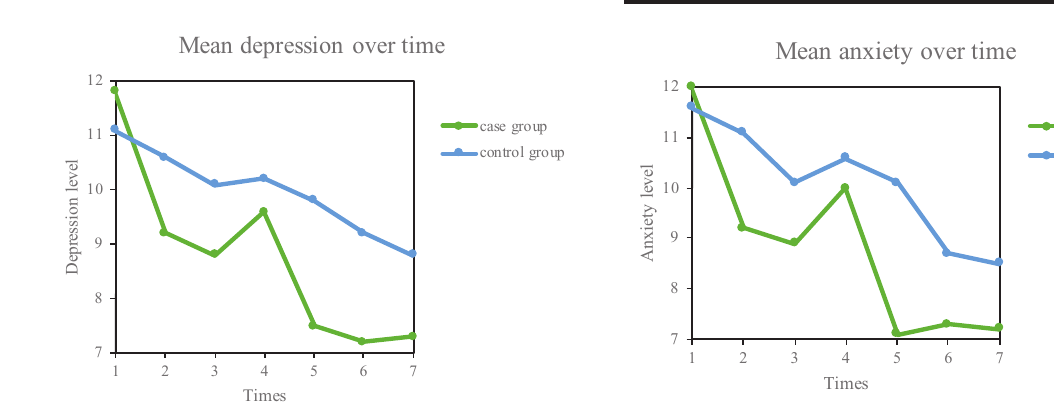
Figure 2. Time trend of mean depression in the intervention and control groups.